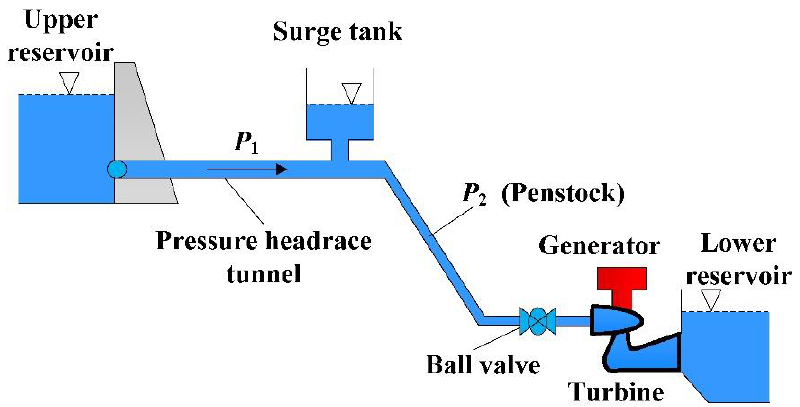
Figure 3. Layout of the pipeline of a hydropower station.